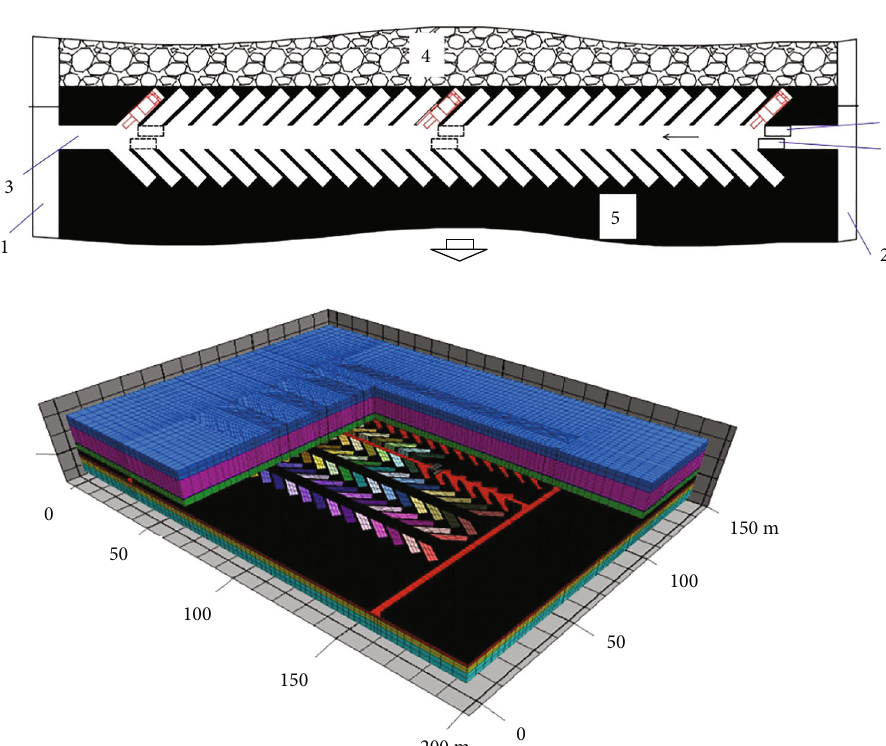
Figure 3: Numerical simulation model of PP supports in di ff erent stages (1-main transport chute; 2-auxiliary transport chute; 3-branch lane; 4-gob side; 5-solid coal side; 6-1# PP support; 7-2# PP